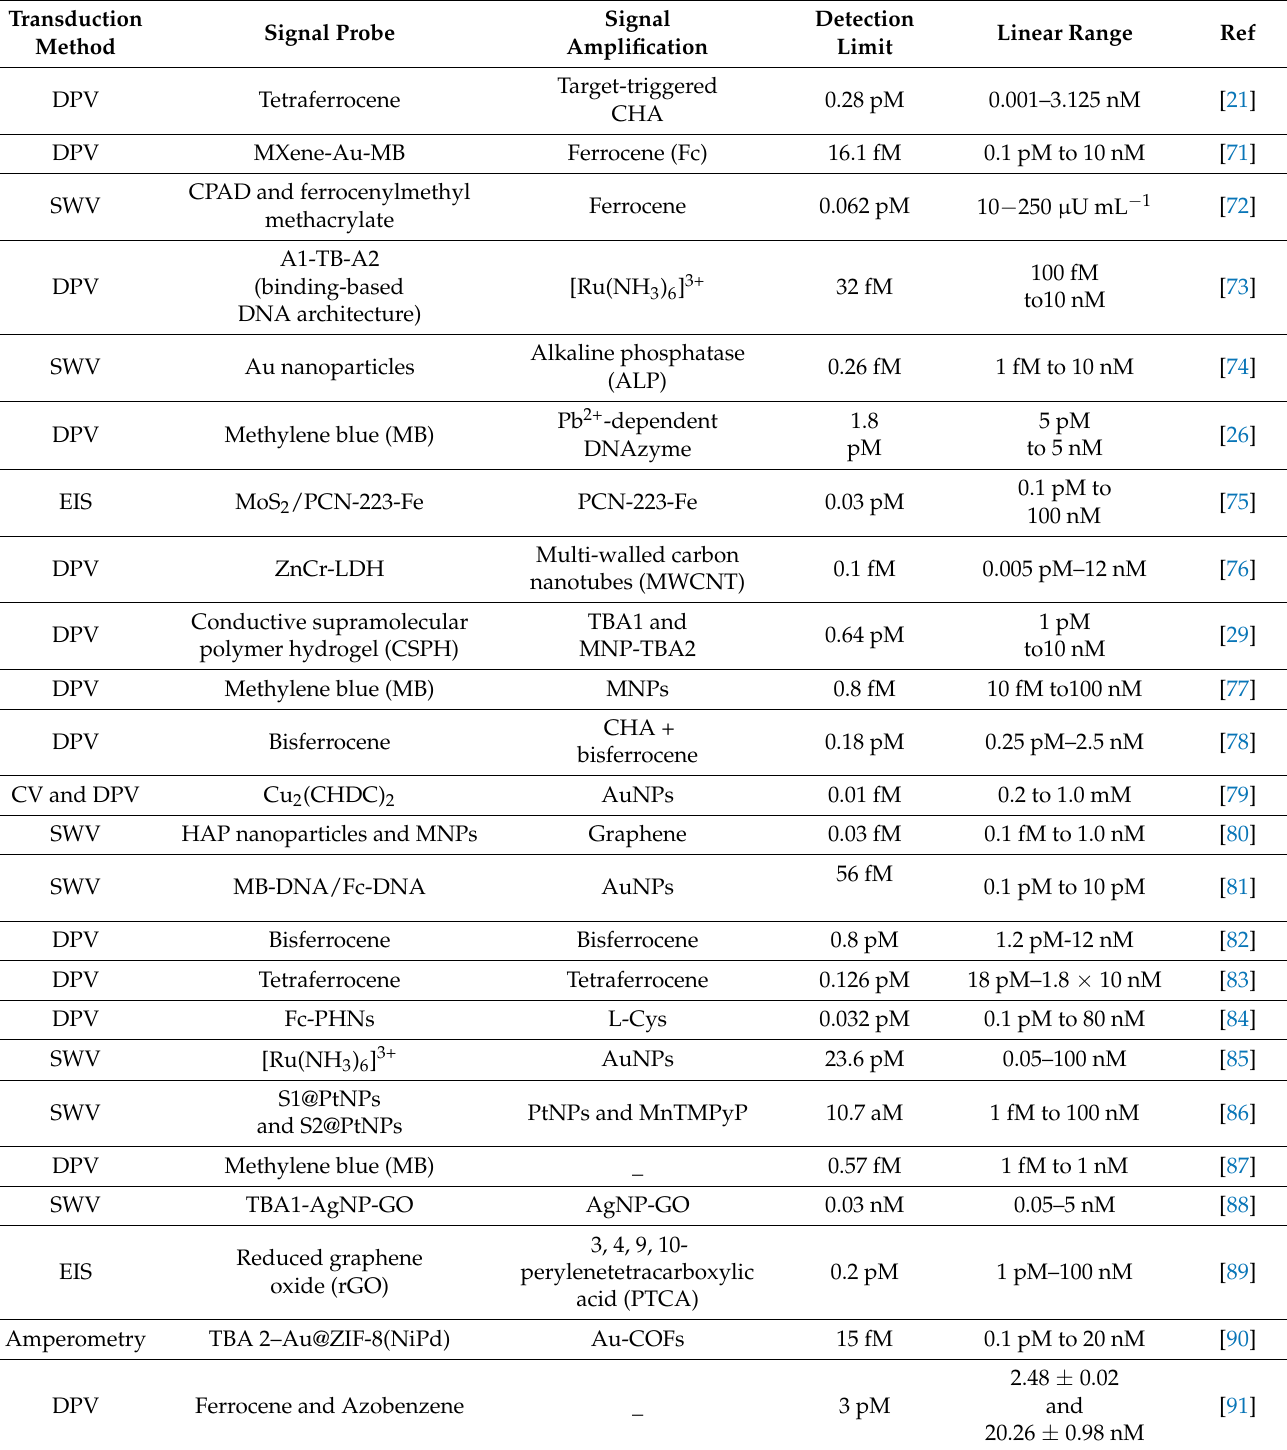
Table 1 summarizes the main characteristics and analytical features of electrochemical biosensors proposed in the literature for the determination of TB. Table 1. The proposed electrochemical biosensors for the determination of